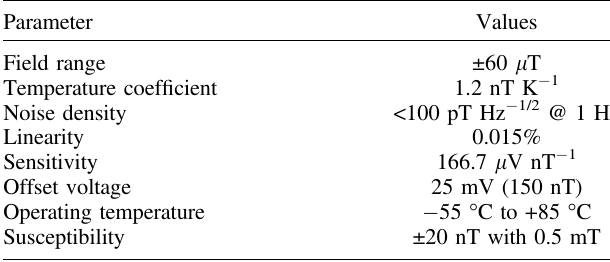
Table 1. LPF magnetometer characteristics (Mateos,